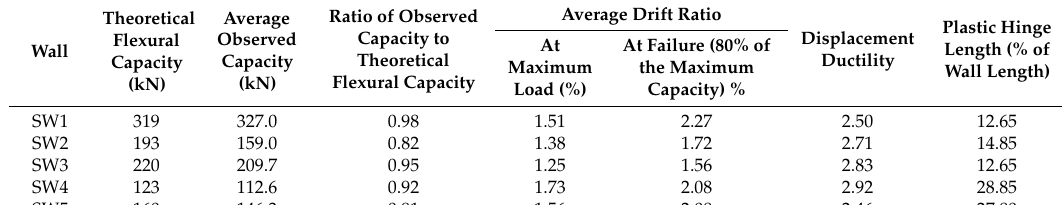
Table 4. Summary of test results.